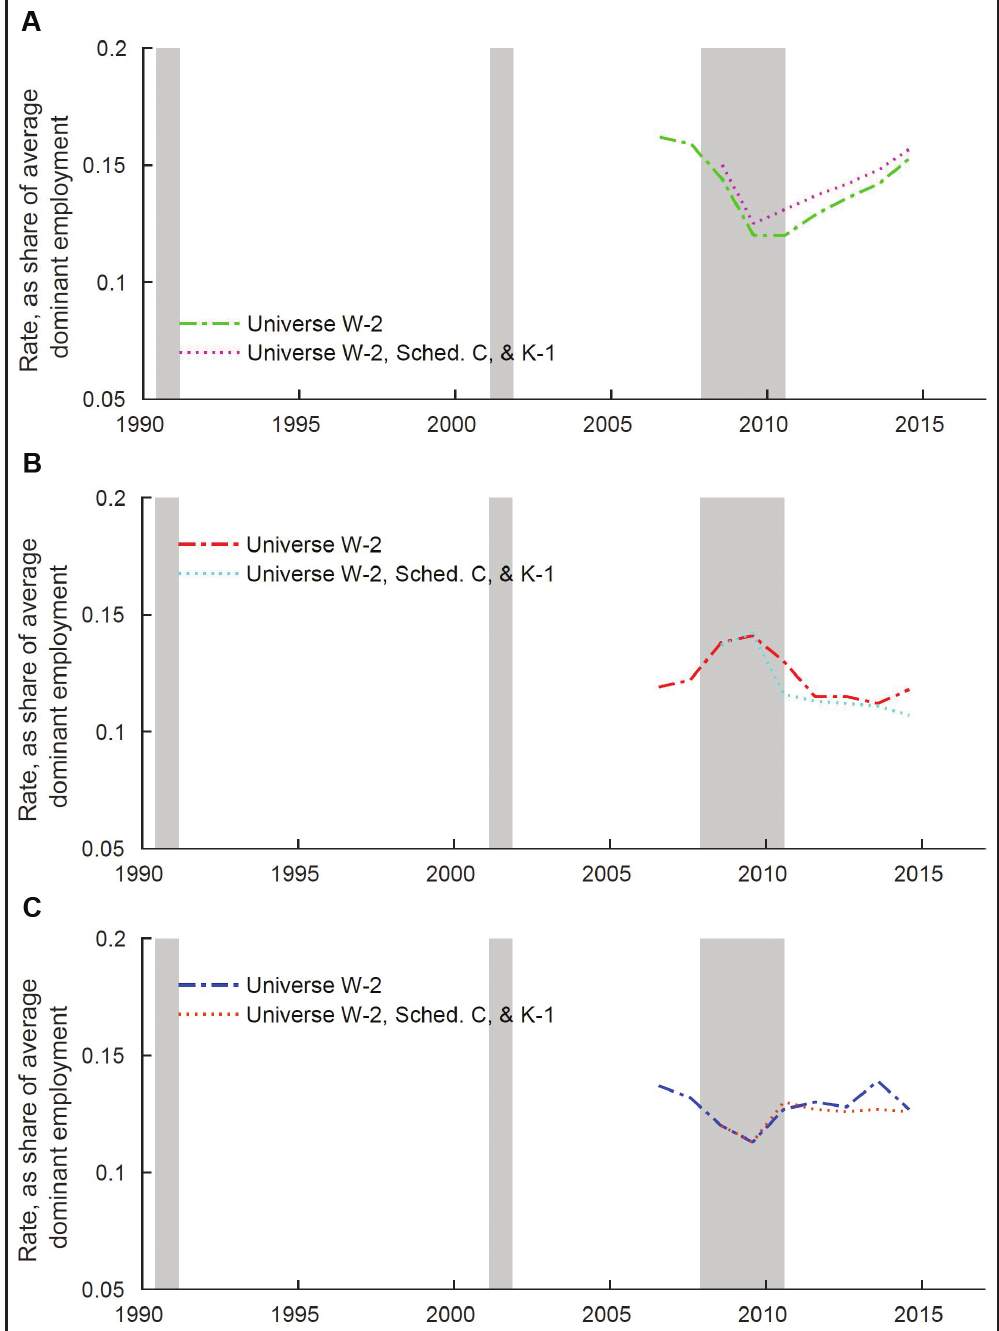
Figure F2 Employer-to-employer and nonemployment